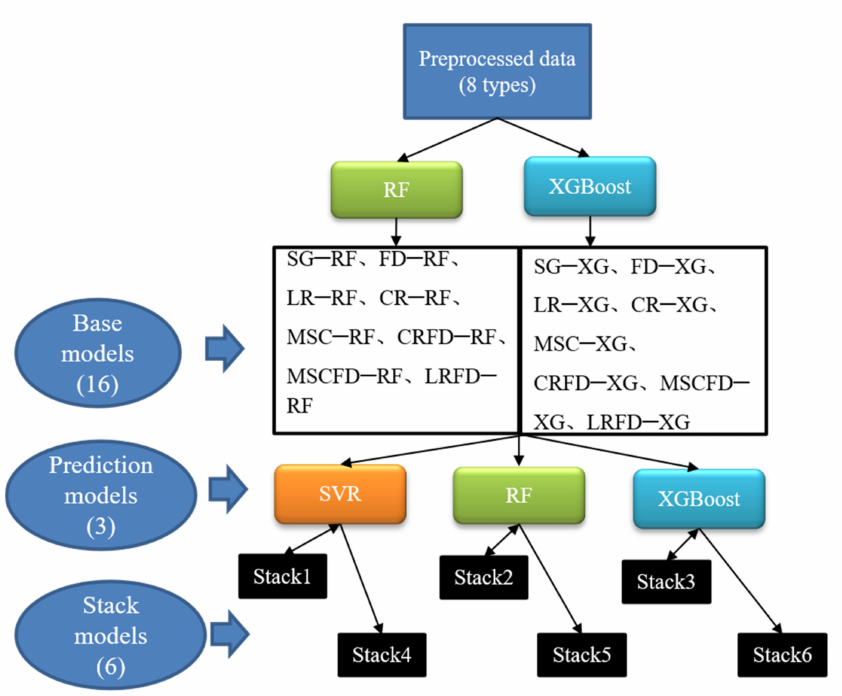
Figure 3. Stacking model processes based on three models and eight pre-processing transformations (SVR is support vector machine regression model, RF is the random forest regression model, XGBoost is the extreme gradient tree regression model. Stack1~ stack3 are stacked models based on 16 preprocessor-model combinations. After modeling Stack1~Stack3, stack4~stack6 are stacked models based on the selection of important variables. The SG is Savitzky–Golay smooth filtering, LR is the logarithmic reciprocal, CR is the continuum removal, MSC is the multivariate scattering correction, FD is the first-order differential, and CRFD, MSCFD and LRFD are the first-order differentials based on CR, MSC and LR,